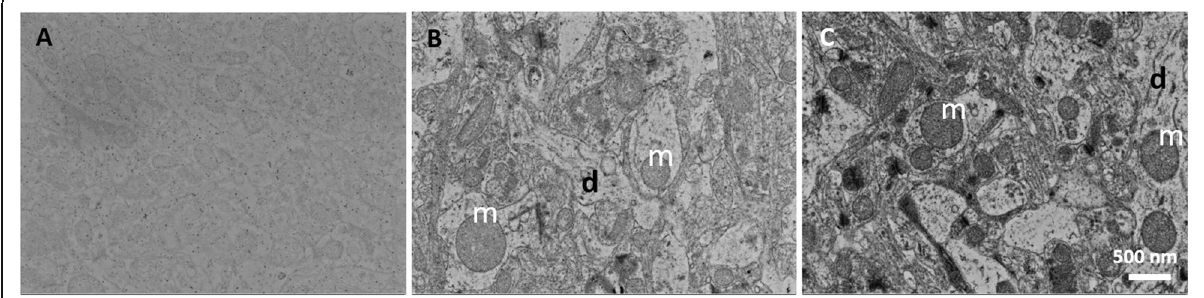
Fig. 2 SEM imaging of one of section from a block without en bloc staining. SEM imaging of one section from a block without en bloc staining. a Without double staining. b Uranyl acetate in distilled water and lead citrate. c Uranyl acetate in 70% methanol and lead citrate. Double staining was effectively enhanced the contrast. Size bar = 500 nm, m: mitochondria, d